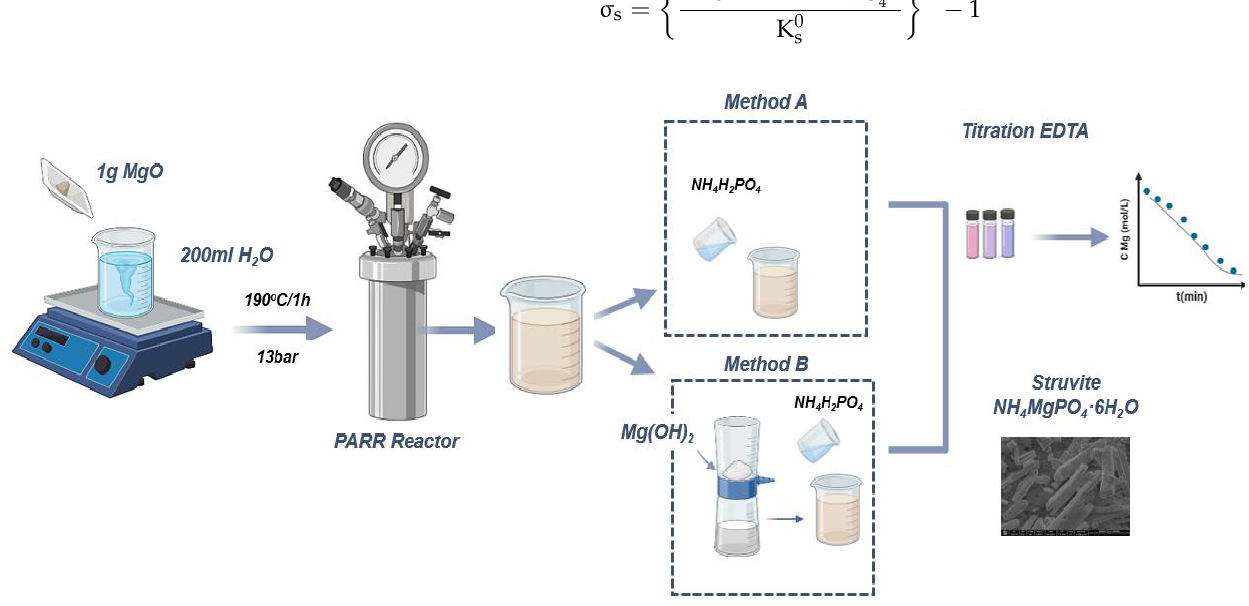
Figure 1. Schematic representation of the experimental methodology for the study of struvite precipitation in supersaturated solutions. For magnesium source, either brucite suspensions (obtained from hydrothermal treatment of MgO) or the supernatant of the suspension.